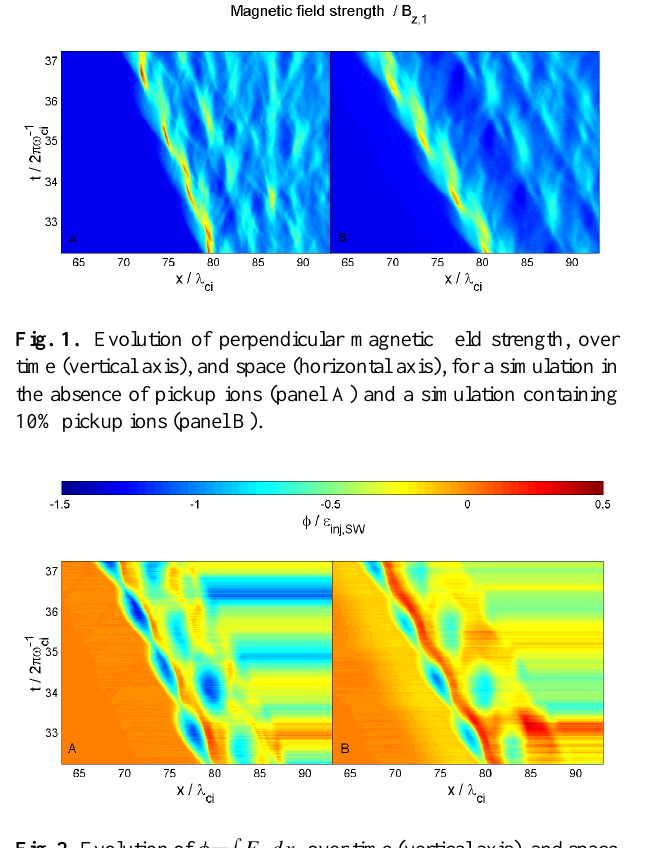
Fig. 2. Evolution of φ = R E x dx , over time (vertical axis), and space (horizontal axis). In the absence of pickup protons (A), and with 10% pickup protons (B).